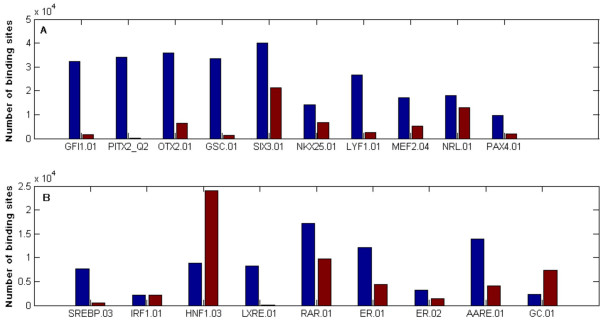
Number of BSs of 19 TFs (selected from the list of 66 – see text) on the 5 Kbp region upstream of 13686 genes. A DNA sequence was considered to be a BS if its score was higher than Tmax. The BS were counted separately for on- Alu (blue) and off-Alu (red) appearances. For 16 out of 19 TFs the majority of the putative BSs reside on Alu. (A) developmental TFs (B) other TFs.